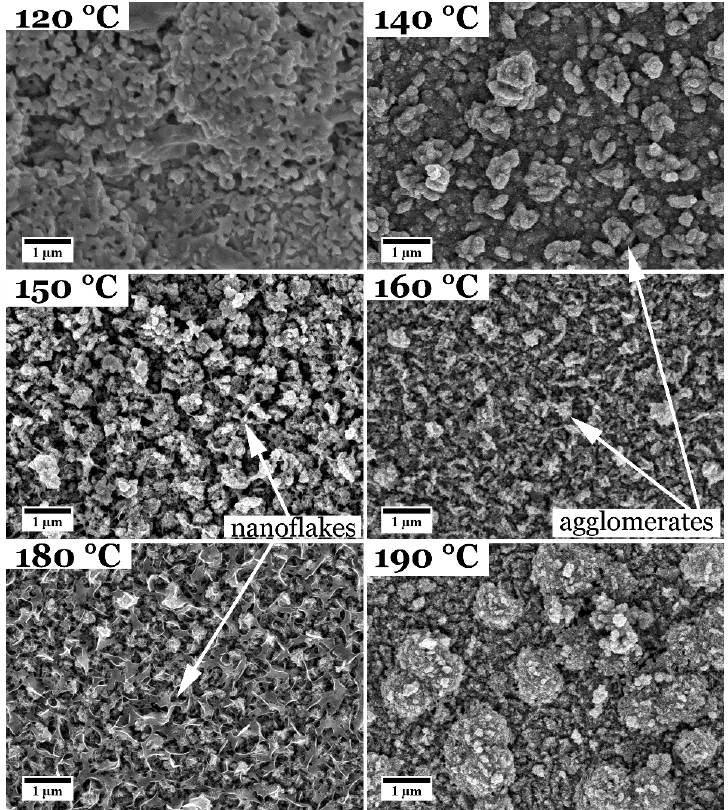
Figure 5. Top-view SEM images of CuInS 2 films synthesized with L -cysteine at different reaction temperatures for 18 h. The temperature for the films shown was varied between 120 and 190 °C.